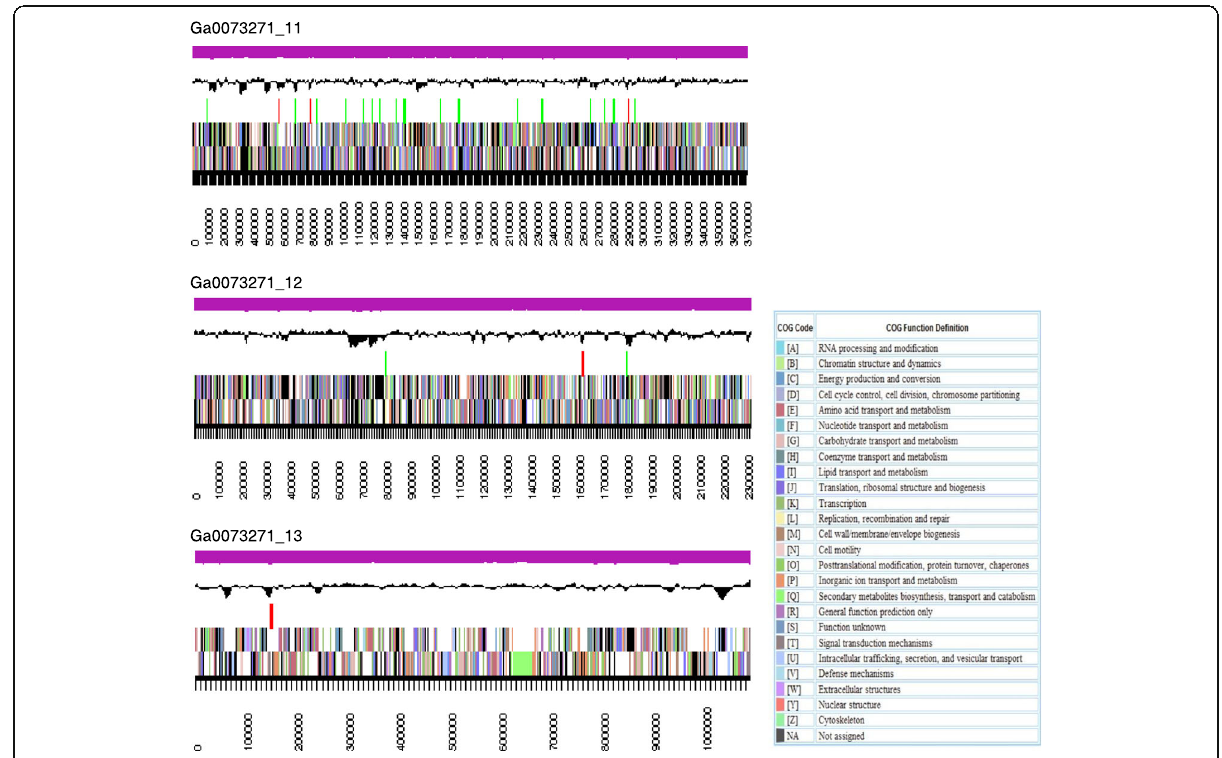
Fig. 3 Graphical map of the 3 scaffolds of the genome of Paraburkholderia caballeronis TNe-841 T . From the bottom to the top of each scaffold: Genes on forward strand (color by COG categories as denoted by the IMG platform). Genes on reverse strand (color by COG categories). RNA genes (tRNAs green, sRNAs red, other black). GC content, GC